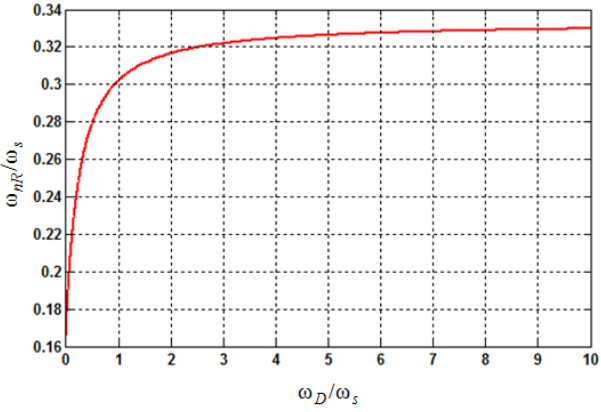
Figure 17. Relationship between ω nR and ω D .